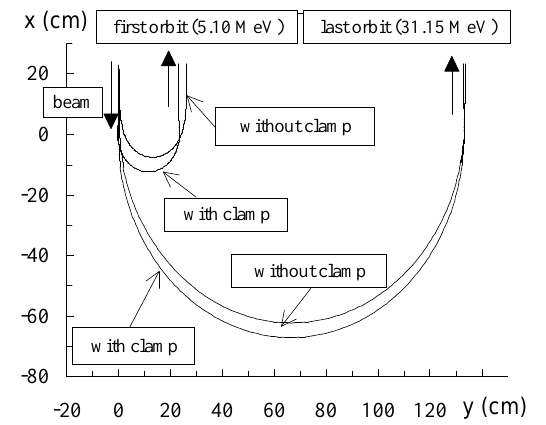
FIG. 3. Trajectories in the presence of the extended fringe field (without clamp) and the reverse fringe field (with clamp), in the middle plane.